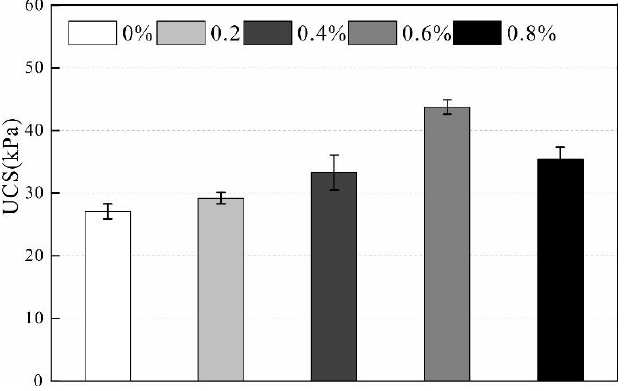
Figure 4. Unconfined compressive strength of wet samples.